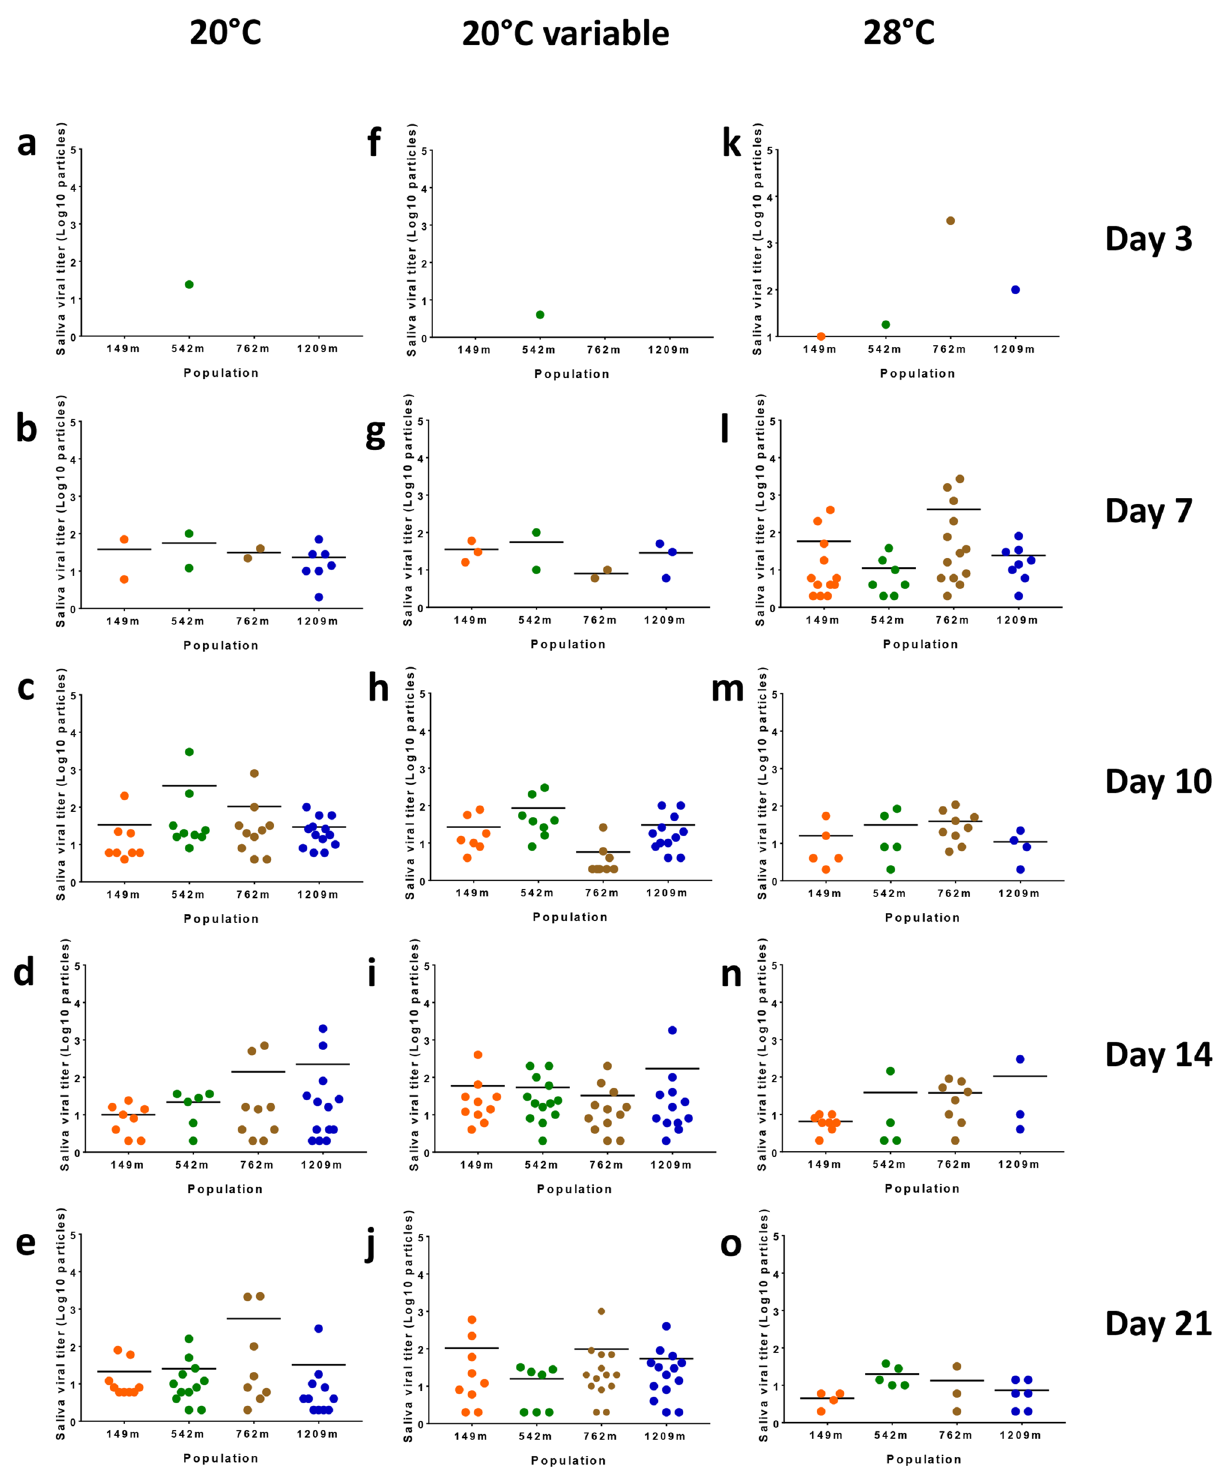
Figure 4. Viral titers in saliva of Ae. albopictus infected with CHIKV and examined at different days (3 ( a , f , k ), 7 ( b , g , l ), 10 ( c , h , m ), 14 ( d , l , n ), and 21( e , j , o )) after incubation at different temperatures (20 °C, 20 °C variable, 28 °C). Saliva was collected from individual females using the forced salivation technique and titrated on C6/36 Ae. albopictus cells. Bars indicate the